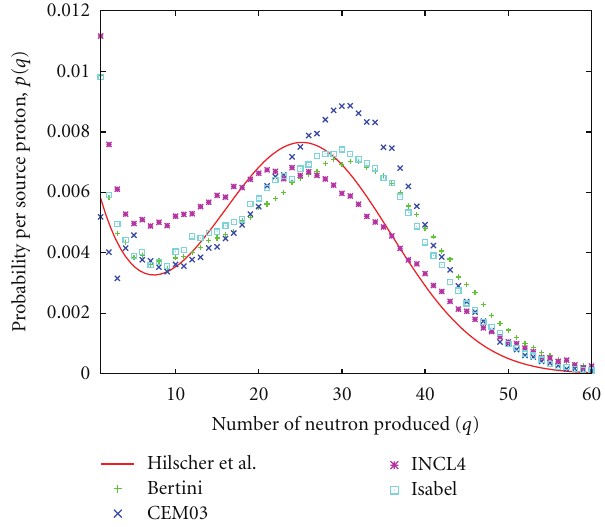
Figure 4: Comparison of measured and simulated distribution of the number of neutrons produced by a source proton for the 5cm thick target.